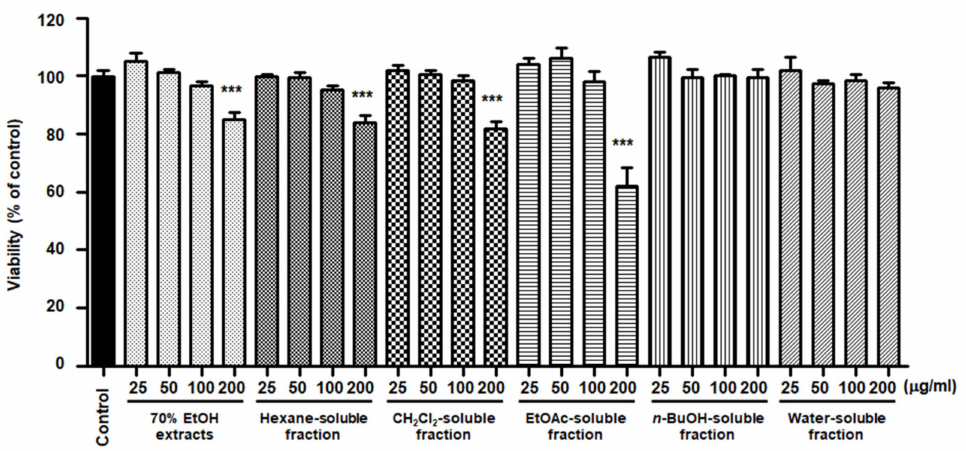
Figure 5. Effects of 70% EtOH extract and its n -Hexane-, CH 2 Cl 2 -, EtOAc-, n -BuOH-, and water- soluble fractions on BV2 cell viability. The cells were treated with S. horneri extract and its fractions for 48 h. Bars represent the mean ± standard deviation of 3 independent experiments. *** p < 0.001. Control means an untreated control